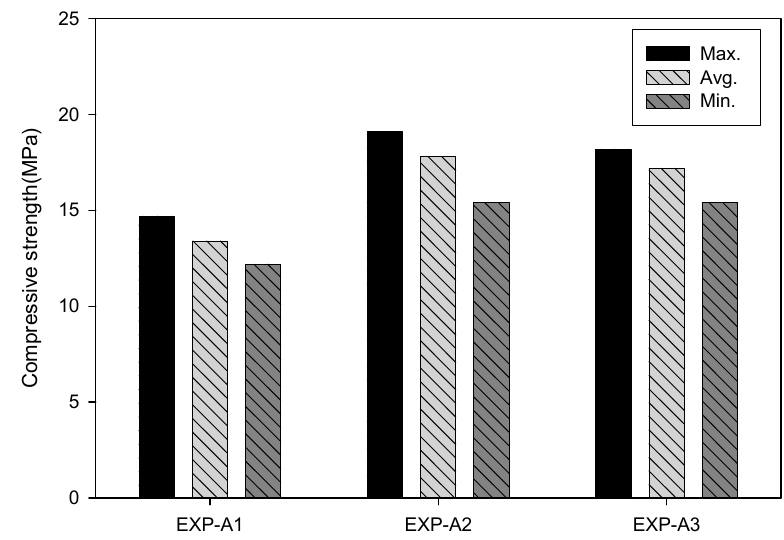
Figure 8. Compressive strength of cement and feldspar mixture.